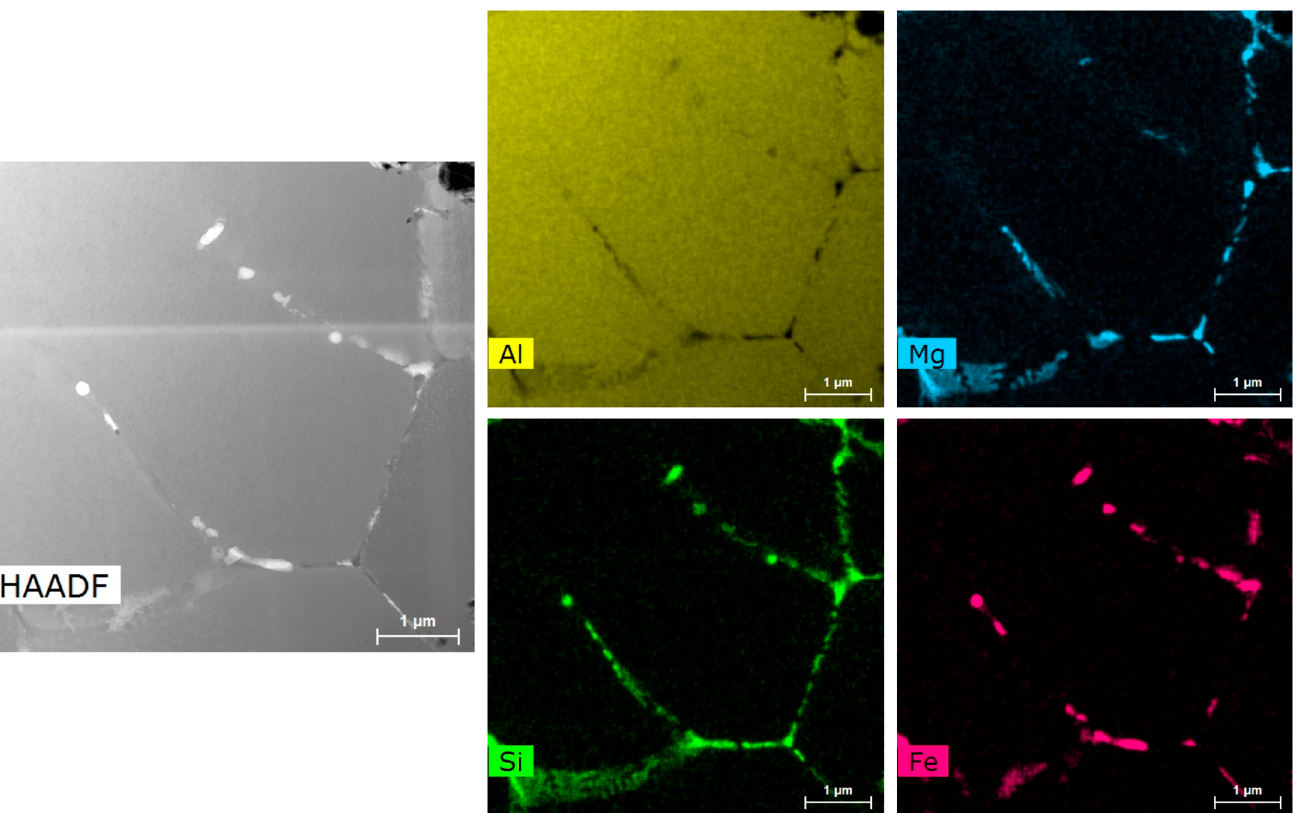
Figure 7. The subfigure labeled with “HAADF” presents a HAADF-STEM micrograph affiliated with a collection of subgrains and sub-granular boundary regions (emphasizing the discrete particles along the boundaries) for an as-atomized Al 6061 powder particle. The colored micrographs labeled with Al, Mg, Si, and Fe present the respective EDS-derived elemental maps for the area presented in the HAADF micrograph. Note that the scale bars are all 1 μ m.